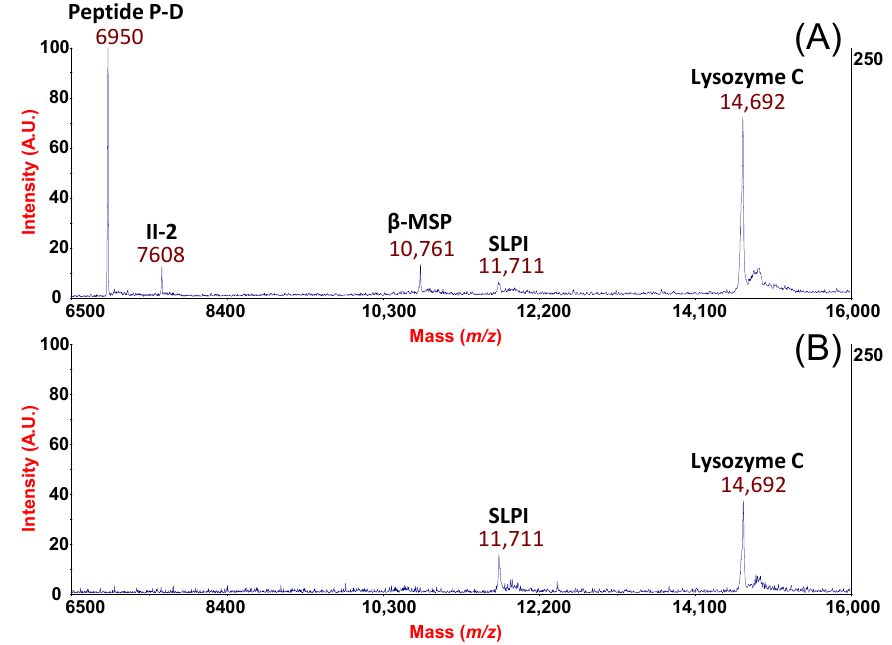
Figure 4. Differential spectra of NF processed by MPS from a patient suffering from AR with no treatment ( A ) and post-treatment ( B ) with azelastine and fluticasone.